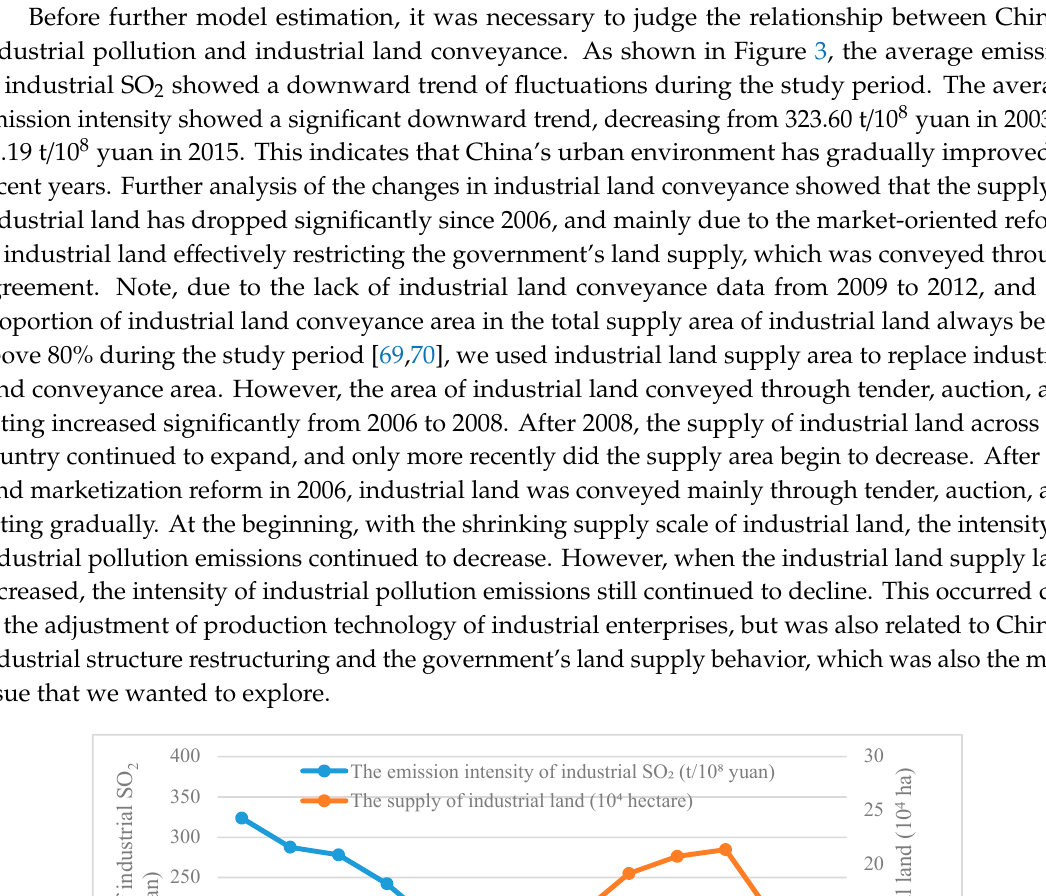
Table 1. Descriptive statistics of the variables used in the model.